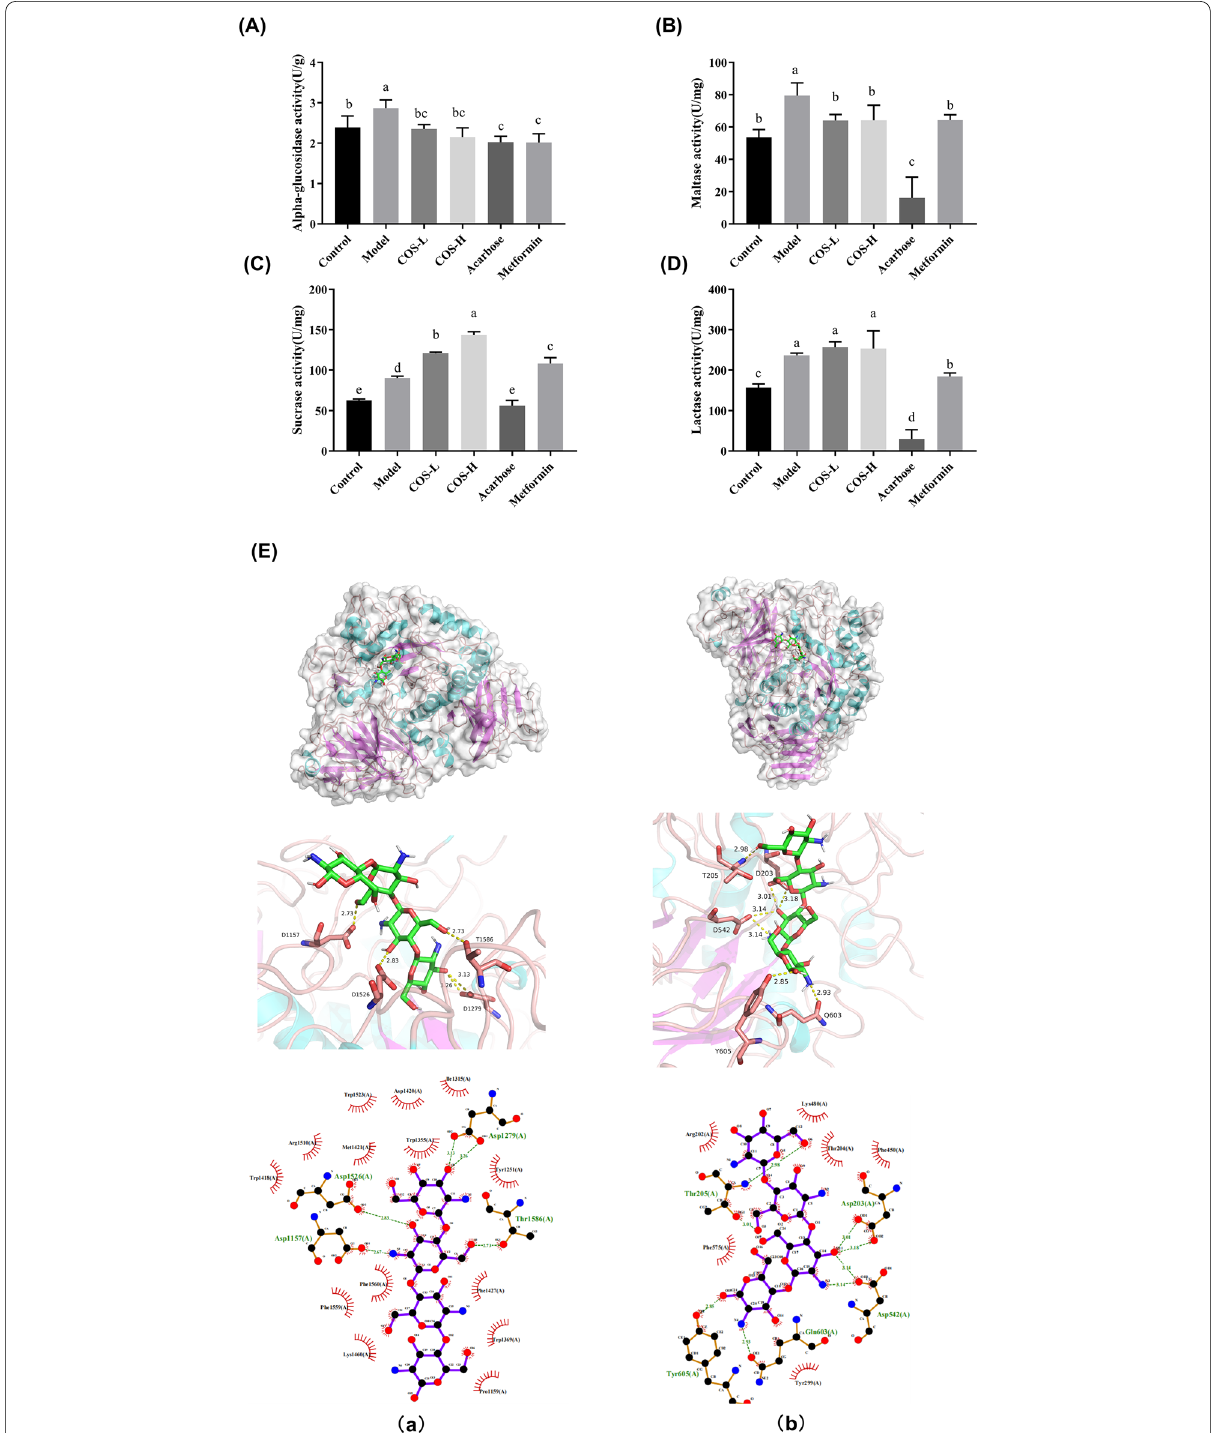
Fig. 6 A The effect of COS on the α-glycosidase activity, B the maltase activity, C the sucrase activity, D the lactase activity, and E molecular docking. A schematic diagram of the optimal conformational interaction between maltose amylase C and COS (Ea). A schematic diagram of the optimal conformational interaction between maltose amylase N and COS